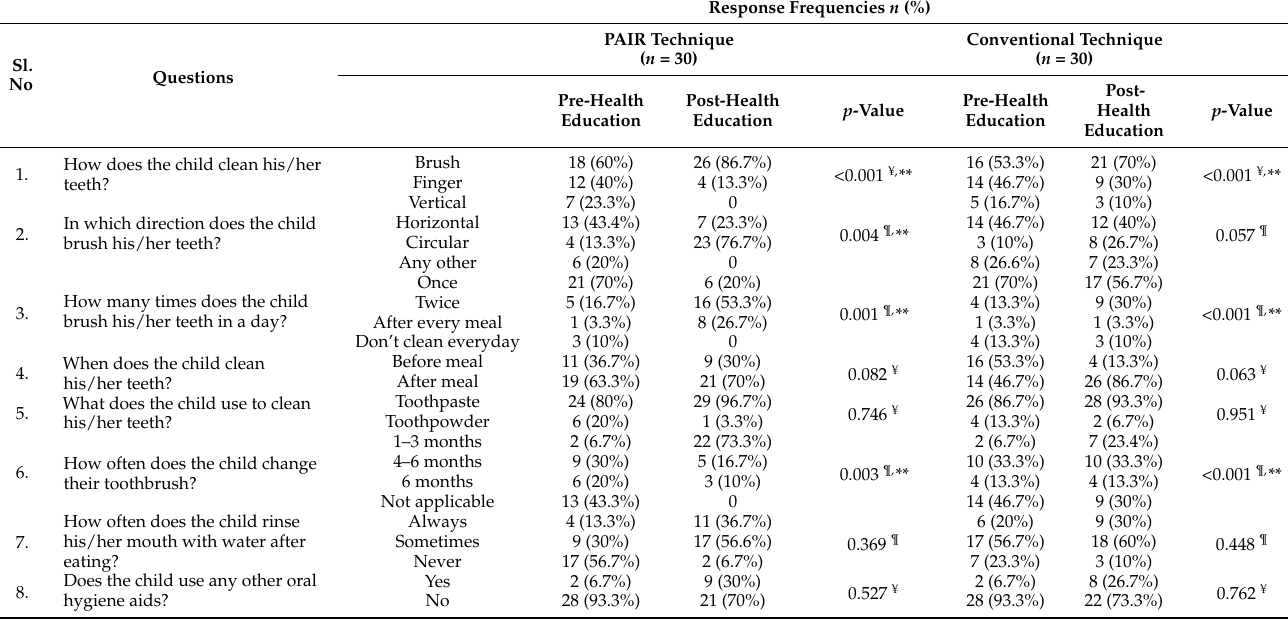
Table 3. Comparison of caregiver perception of oral hygiene practices in the study population under PAIR technique and conventional technique before and after the intervention.